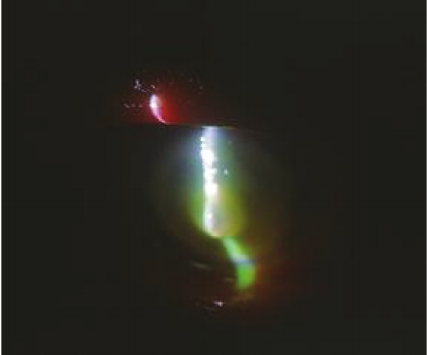
Figure 1: Clinical picture of the right eye at initial presentation. There is marked corneal infiltration, and central thinning.